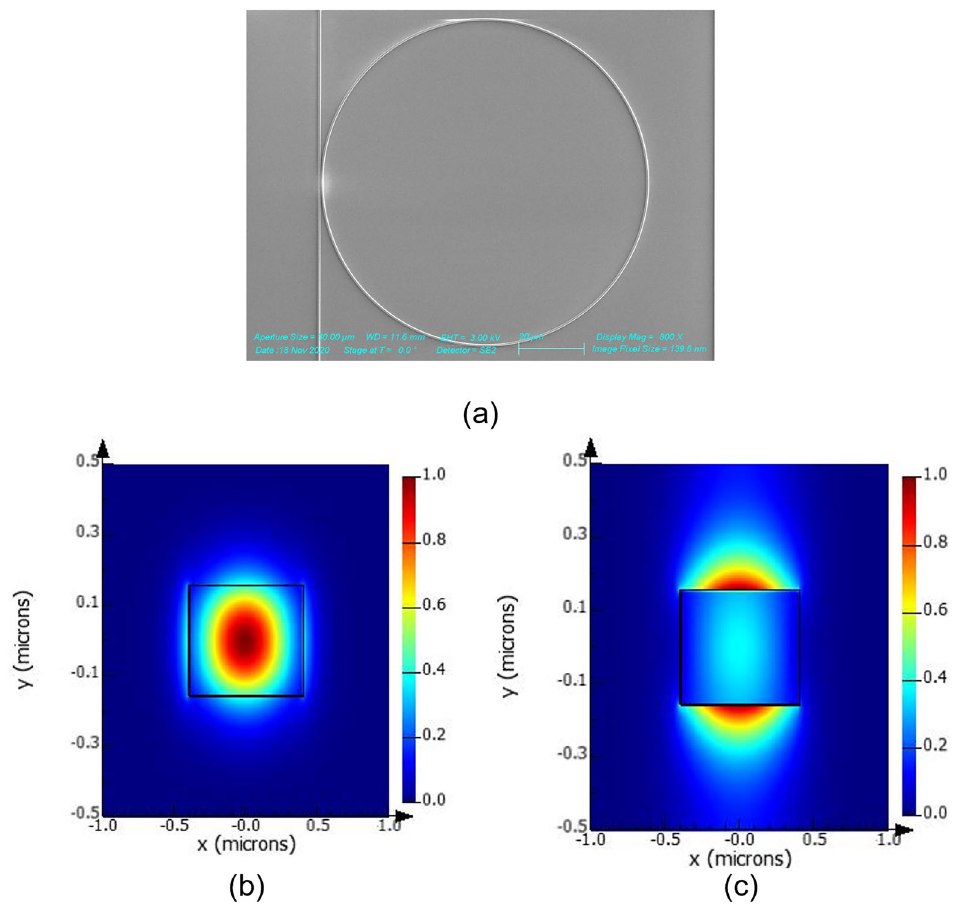
Figure 2. ( a ) SEM Micrograph of all-pass ring resonator ( b ) Mode Profile of Quasi-TE mode at 1.55 µm ( c ) Mode Profile of quasi-TM Mode at 1.55